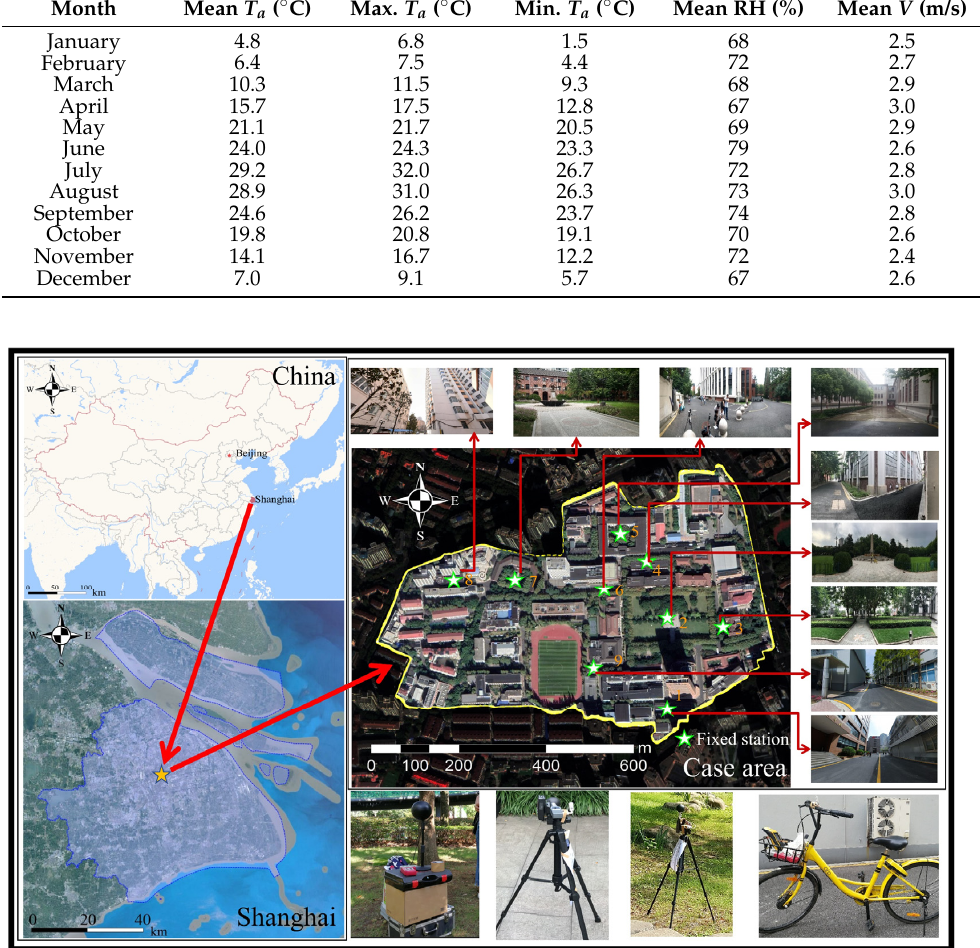
Figure 1. Location of the case study campus in Shanghai and the distribution map of test sites in the campus.